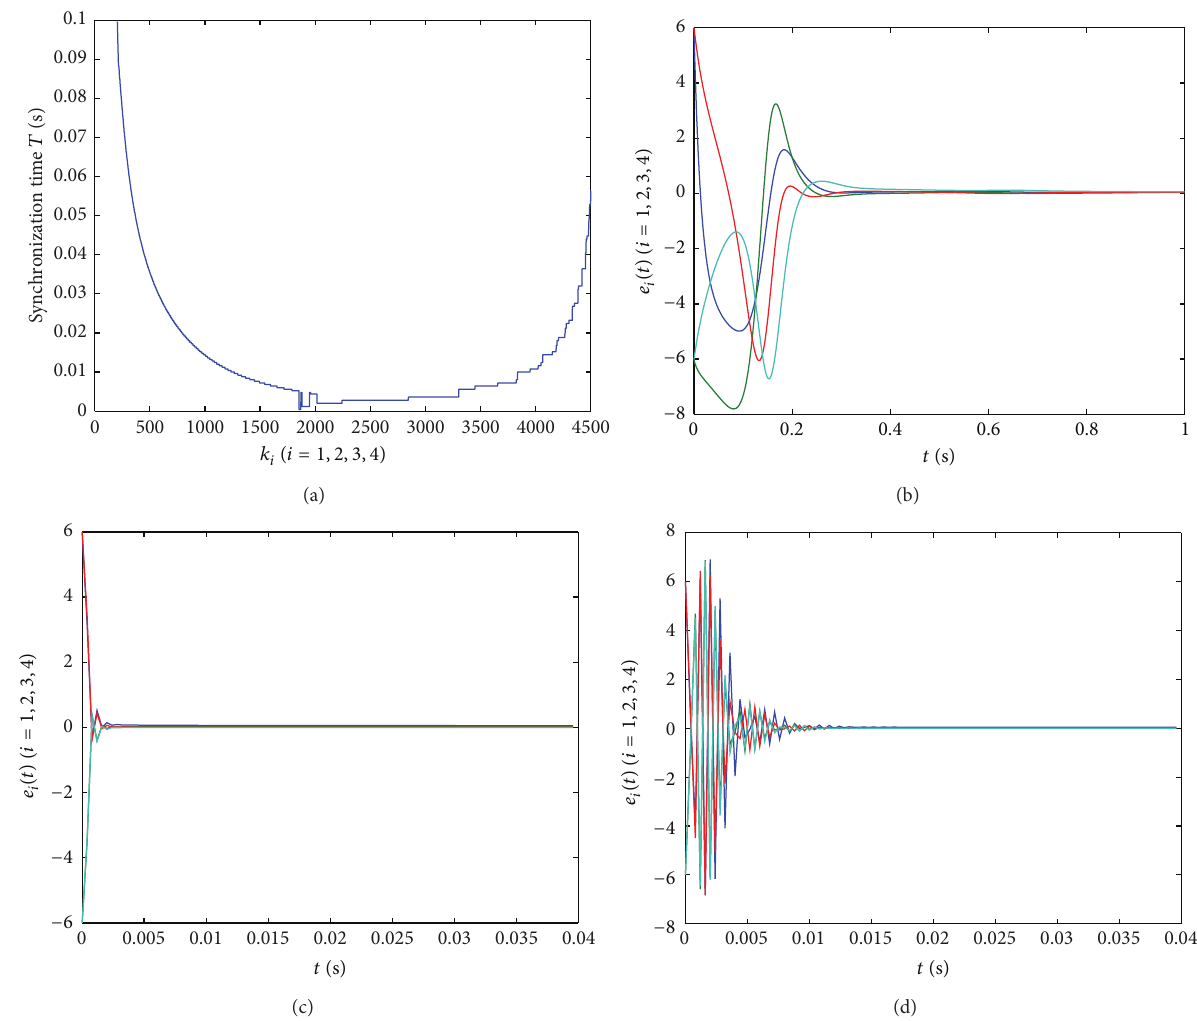
Figure 9: The waveform of synchronization time with the control parameters 𝑘 𝑖 (𝑖 = 1,2,3,4) (a) and time waveforms of synchronization errors between two hyperchaotic L¨u systems with parameter 𝑘 𝑖 = 20 (b), 2000 (c), 4000 (d) (𝑖 = 1,2,3,4) ,